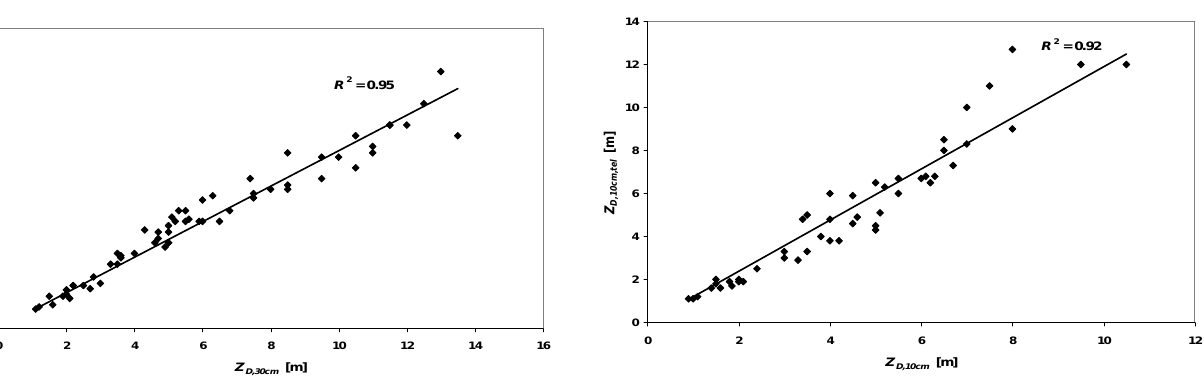
Fig. 4. All naked eye and colour filter observations of Z D with a 10cm disk as a function of the observations with a 30cm disk. The best-fit line through the origin is the function Z D,10 cm = 0.83 Z D,30 cm .